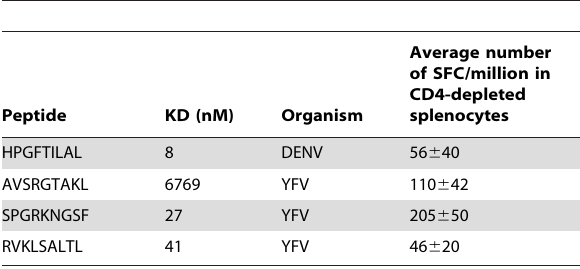
Table 1. ELISPOT results on peptide pool-immunized A*02:01 mice.